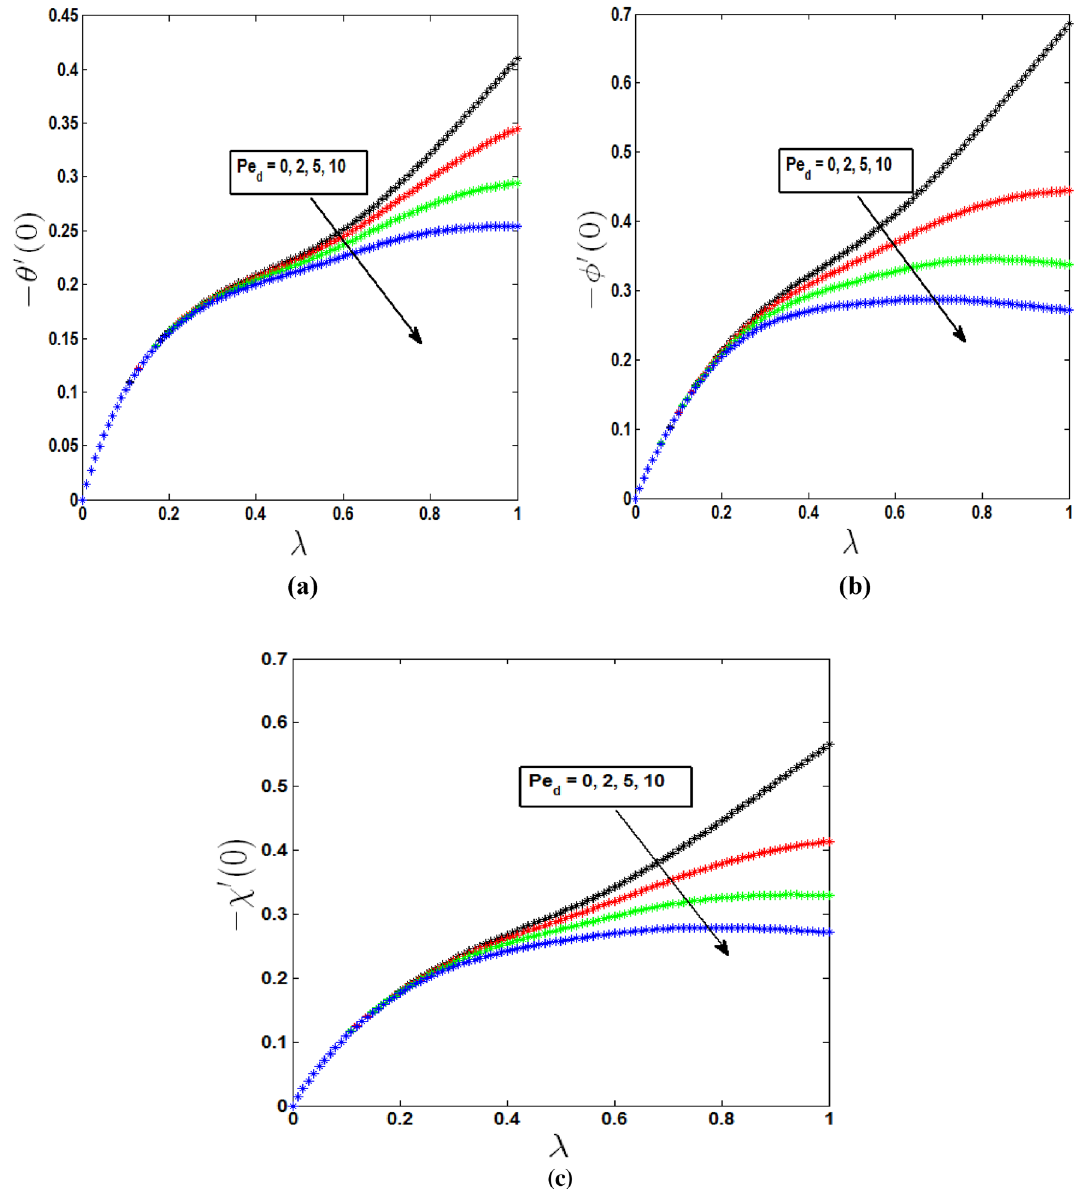
Figure 6. Dispersion effects on ( a ) heat transfer rate, ( b ) mass transfer rate, ( c ) motile microorganism transfer rate in free, forced and mixed convection